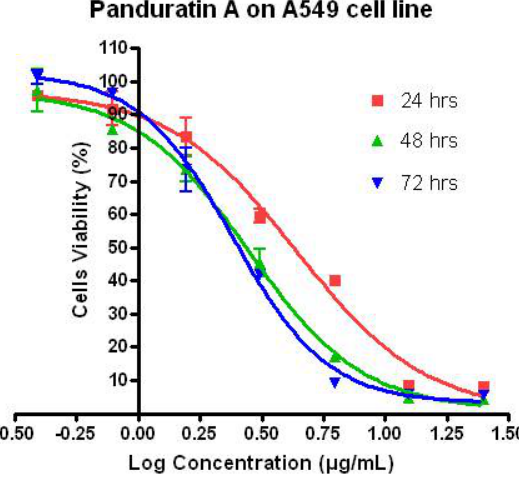
Figure 3. Dose response curves (using GraphPad Prism) of panduratin A tested in the MTT assays at 24, 48 and 72 hours treatment.